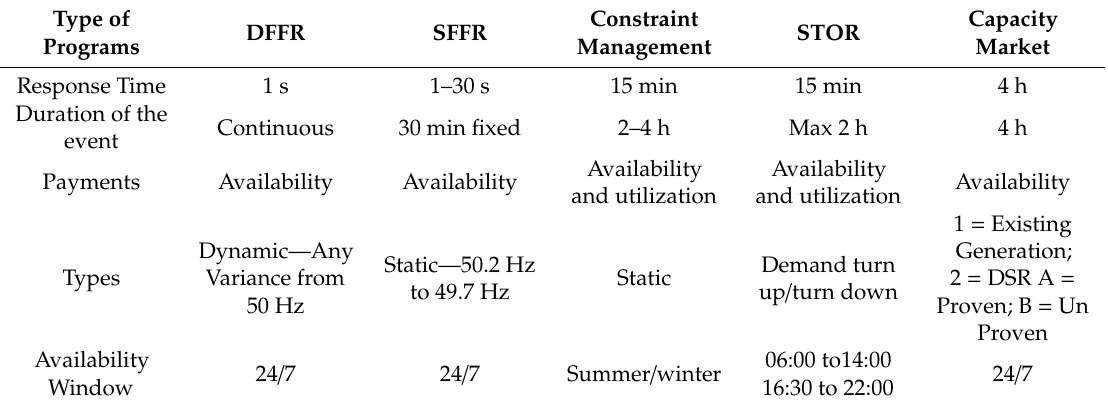
Table 1. Demand response programs example for the U.K. balance